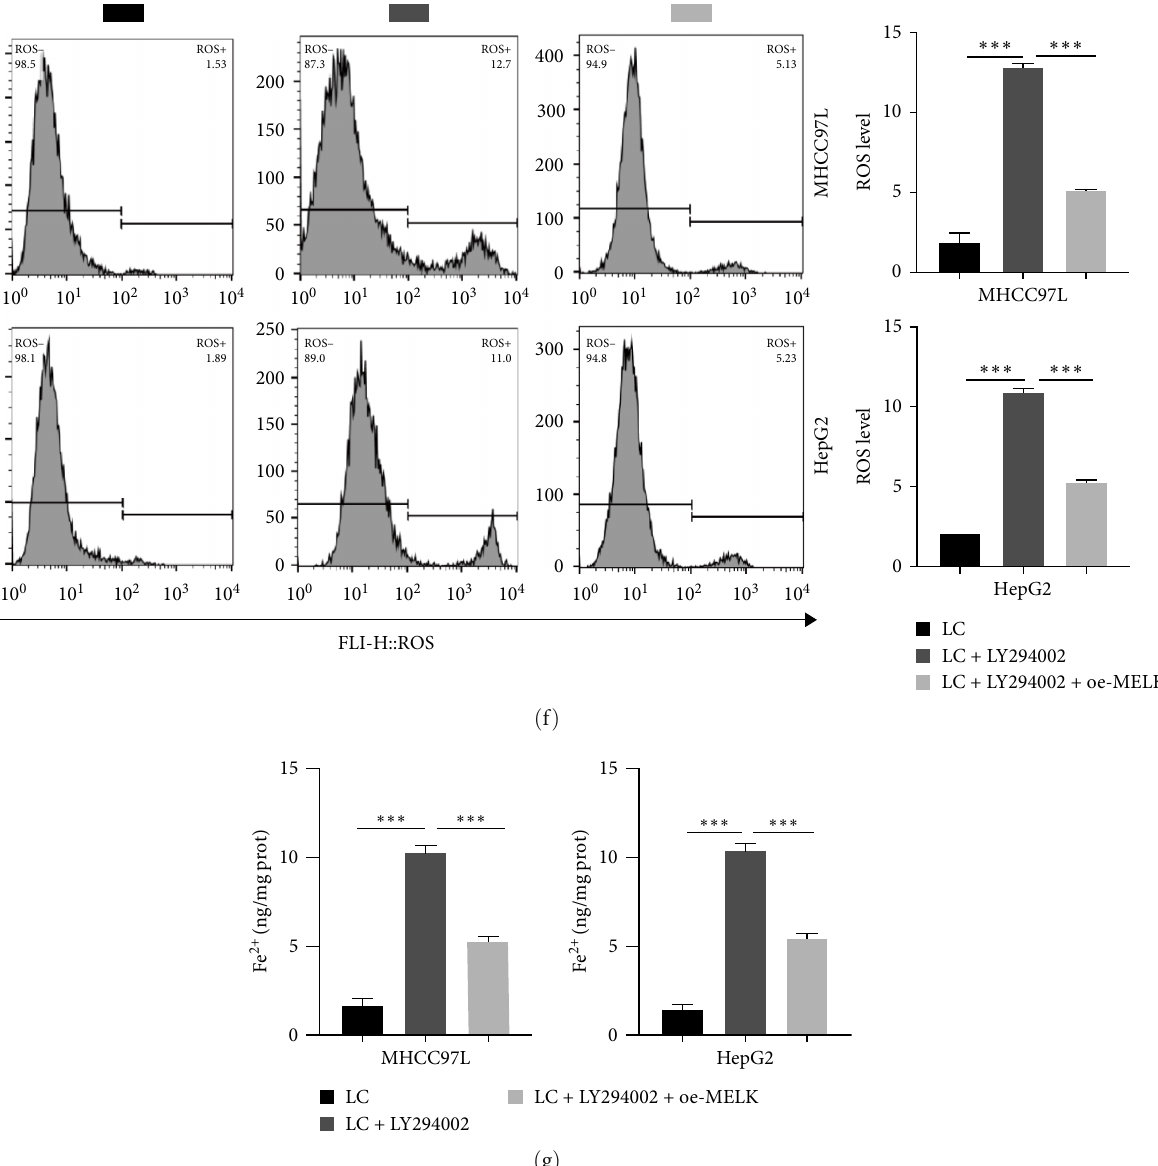
F IGURE 4: MELK inhibits liver cancer cell ferroptosis through AKT/mTOR: (a) coimmunoprecipitation to verify the interaction between MELK and AKT; (b) CCK8 for cell viability; (c) Western blot for the level of MELK, AKT, mTOR, p-AKT, and p-mTOR; (d) Western blot for the level of ferroptosis-related proteins GPX4, HO-1, FTH1, and x CT; (e) kit assay for the level of GSH; (f) fl ow cytometry to detect ROS content; (g) kit assay to detect the Fe 2+ content, ∗ P < 0 : 05, ∗∗ P < 0 : 01, ∗∗∗ P < 0 :